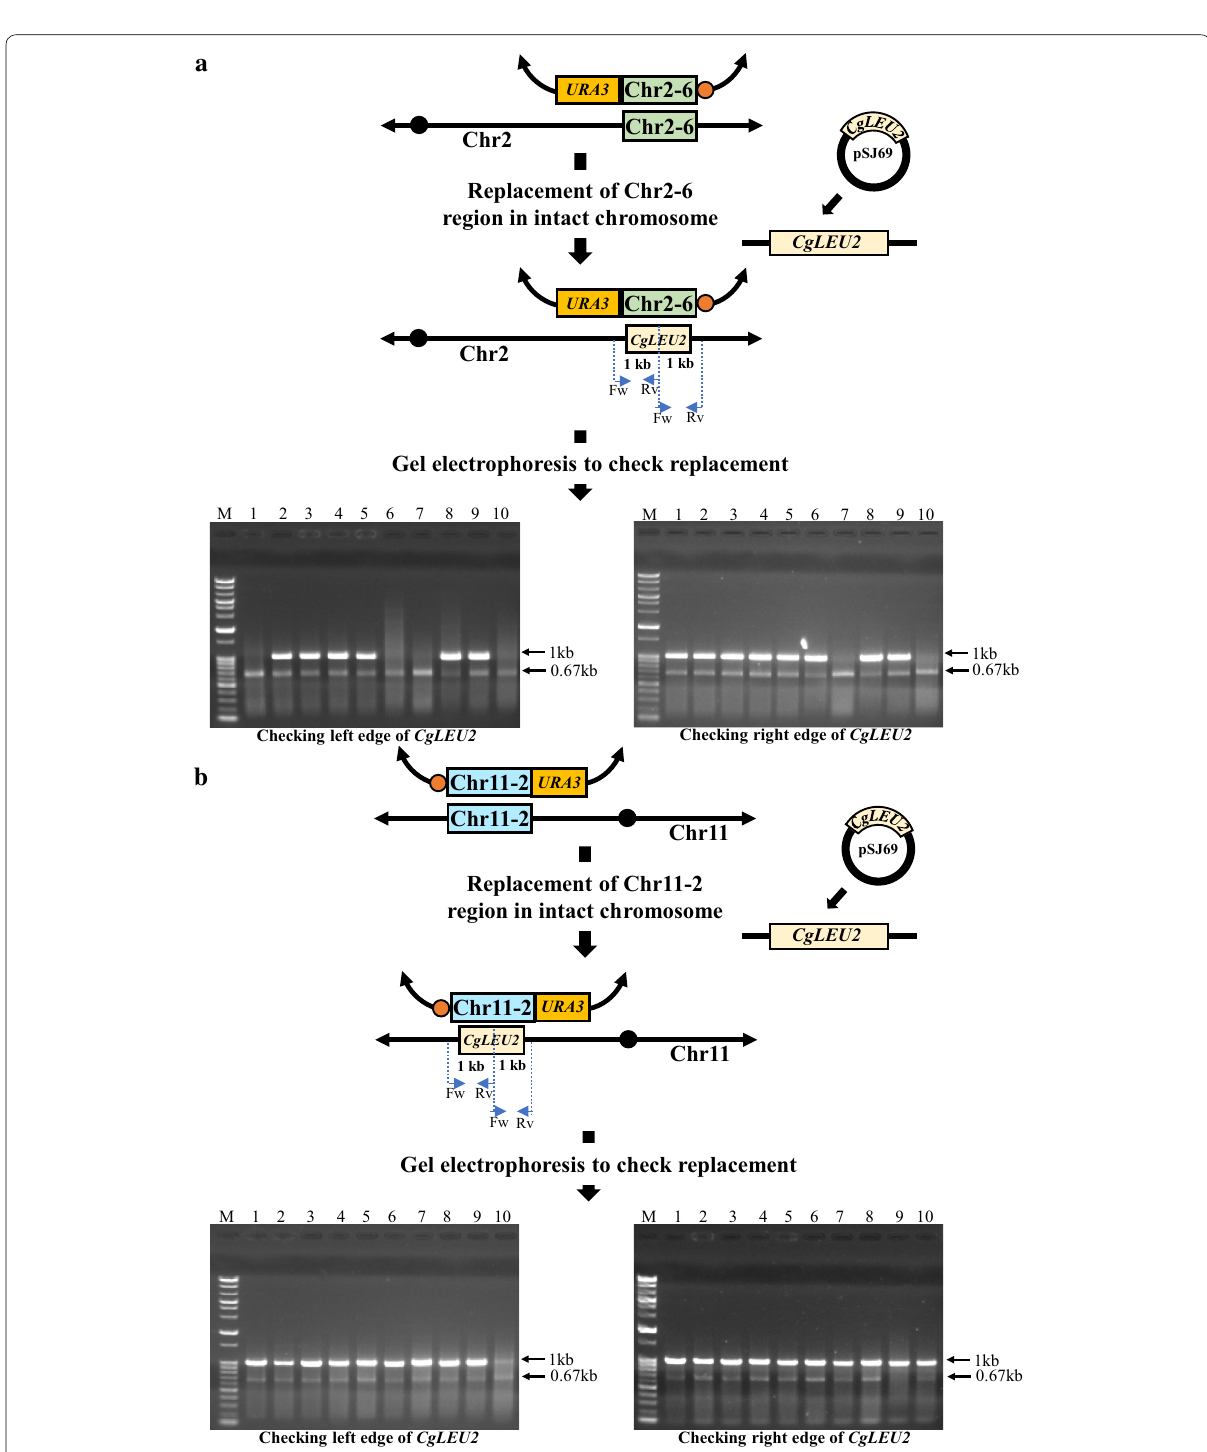
Fig. 7 Checking Chr2-6 (dup rep) and Chr11-2 (dup rep) transformants. Upper part of a , b represents DNA module (synthesized from the + + plasmid pSJ69 as template contained CgLEU2 ) was introduced into Chr2-6 and Chr11-2 duplicated transformants to replace Chr2-6 and Chr11-2 regions from the intact chromosome, respectively. Bottom part of a , b represents gel electrophoresis of colony PCR and each lane represents independent transformants without the most left lane, which contains size marker. In a , SJP 118 and SJP 119 were used to check left edge of CgLEU2 whereas SJP 127 and SJP 385 were used to check right edge of CgLEU2 for the replacement of Chr2-6 region in Chr2-6 duplicated transformants, respectively. In b , SJP 219 and SJP 119 were used to check left edge of CgLEU2 whereas SJP 127 and SJP 387 were used to check right edge of CgLEU2 for the replacement of Chr11-2 region in Chr11-2 duplicated transformants,